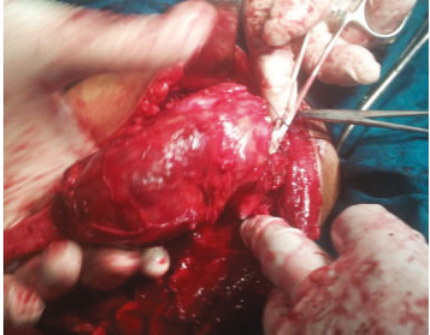
Figure 11: Excision of lesion was done with a ff ected soft tissue and bone.